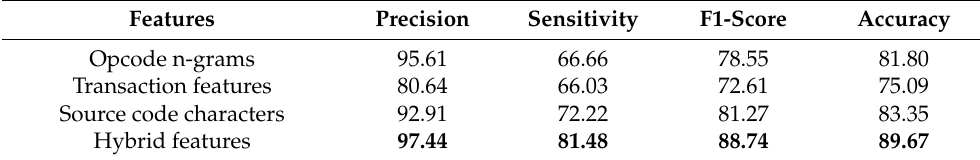
Table 6. Evaluation of the proposed feature set using the ensemble classifier.